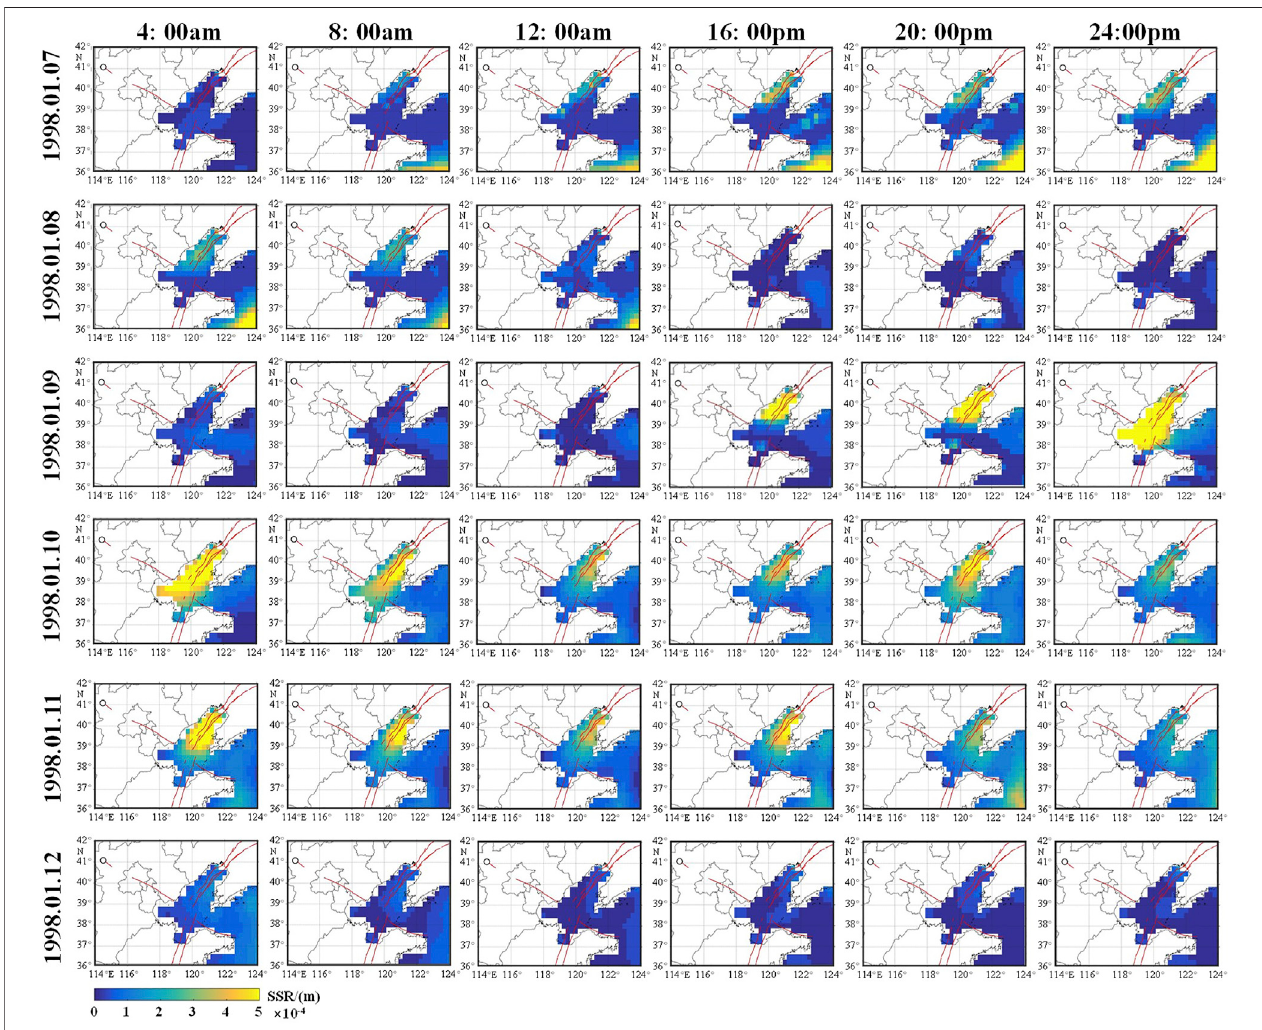
FIGURE 4 | The change of SSR pattern over Bohai Sea from 7 to 12 January